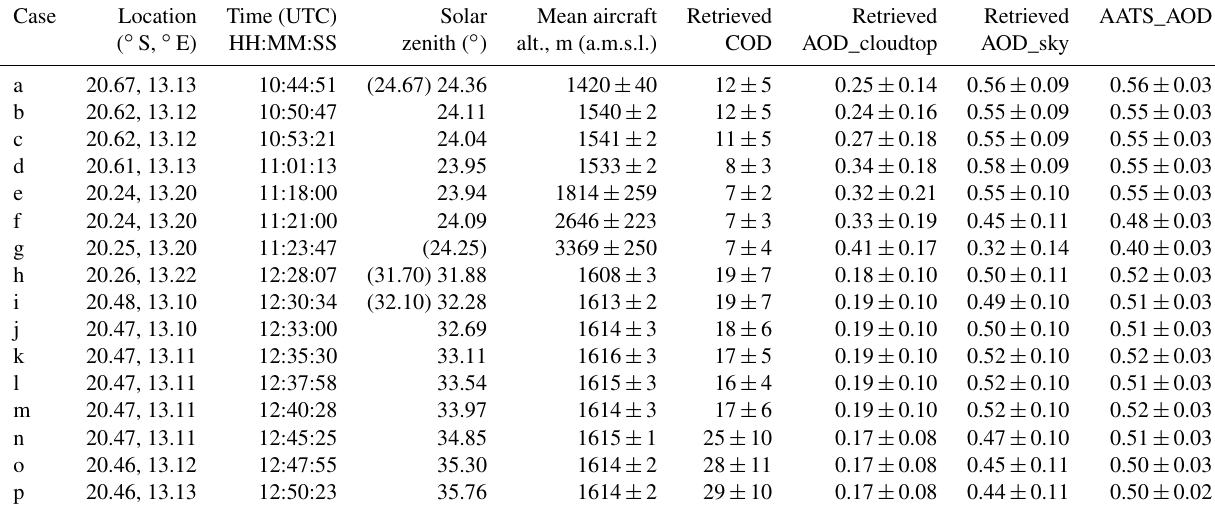
Table 1. Retrieved parameters from a total of 16 CAR bidirectional reflectance–distribution function (BRDF) cases taken on 13 September 2000 during the SAFARI 2000 campaign. AOD values are derived at λ = 0.500µm.